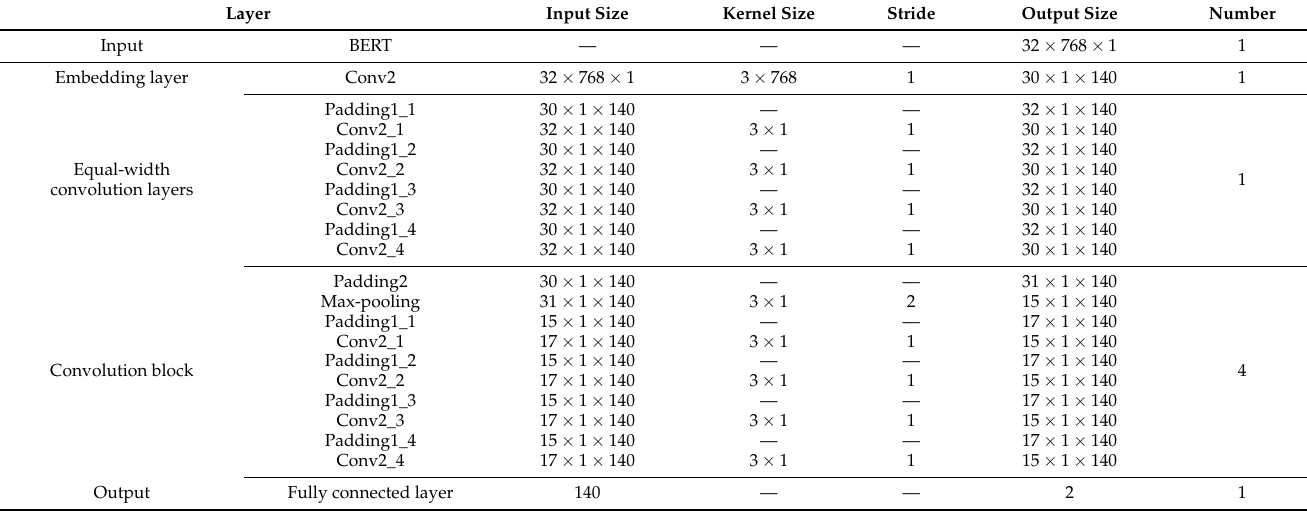
Table 4. The detailed structure parameters of the